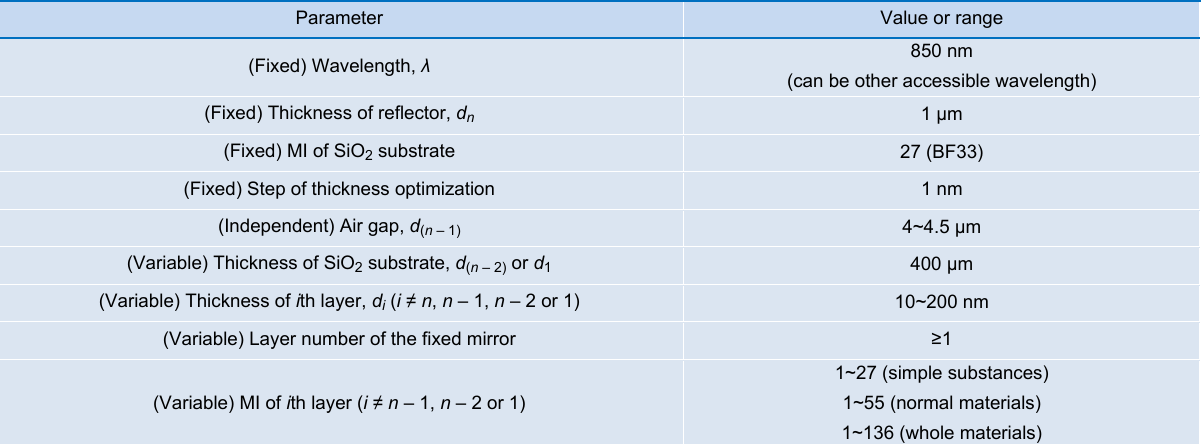
Table 1 | Parameters of inverse